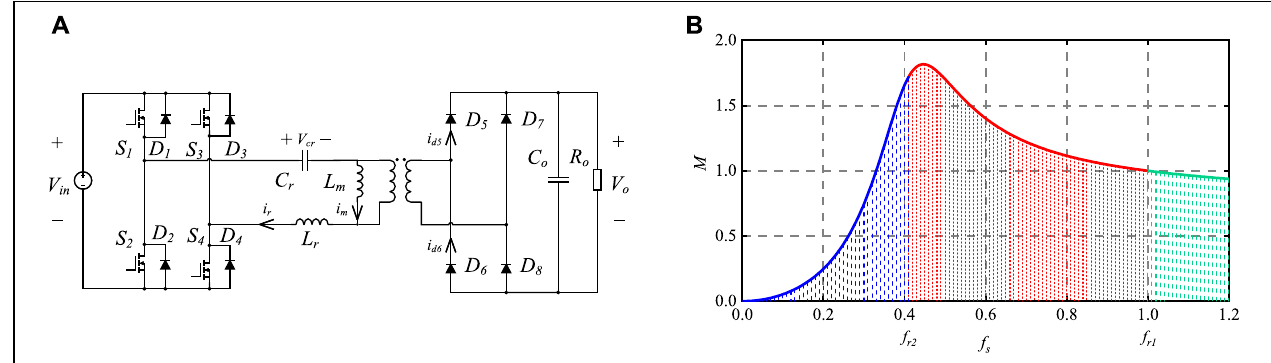
FIGURE 1 | (A) Structure of single-phase LLC resonant converter, and (B) input–output voltage gain curve of LLC resonant converter.